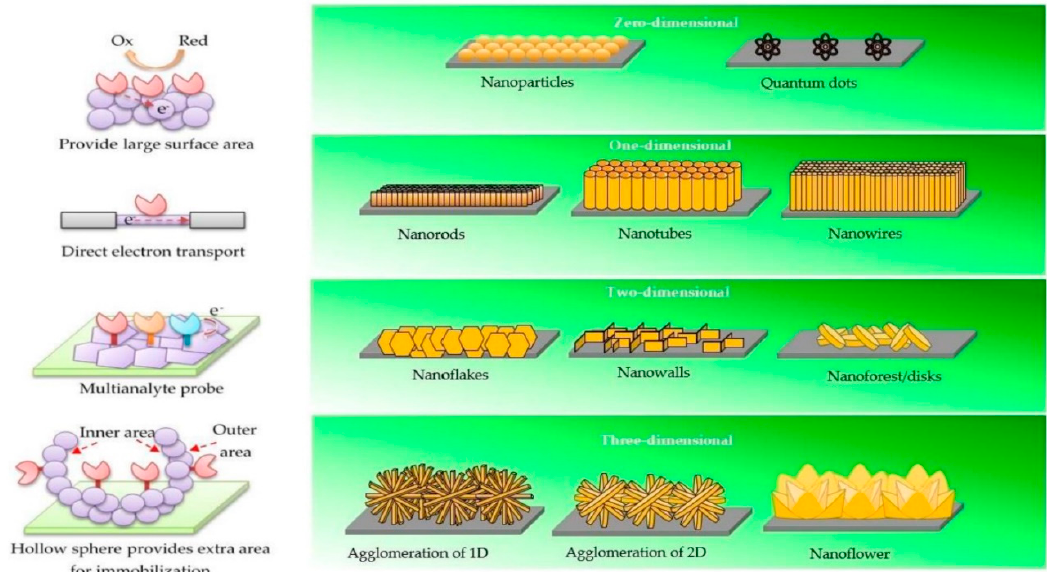
Figure 6. Four different dimensions of ZnO nanostructures with their advantages. Zero-dimensional nanostructures provide a large surface area. One-dimensional nanostructures possess stable and direct electron transport. Two-dimensional nanostructures give specific planes for immobilization process for the simultaneous detection of different analytes. Three-dimensional nanostructures have extra surface area (outer and inner area) to provide more sites for immobilization. Adopted from [27]. poly(acrylonitrile) (PAN) fibers, to enhance the UV detection capabilities. Diethyl zinc